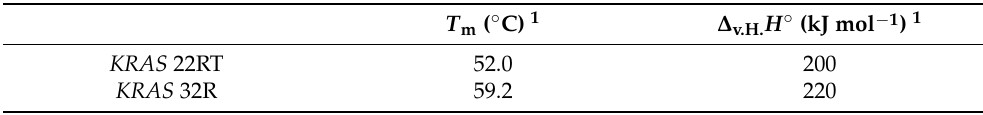
Table 1. Thermodynamic parameters calculated by the van ’t Hoff analysis of the circular dichroism (CD) melting curves.